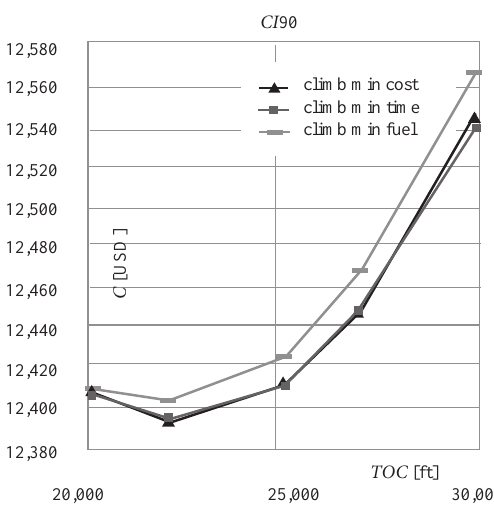
Fig. 9. Comparison of en route flight total costs for three types of climb techniques, CI = 90